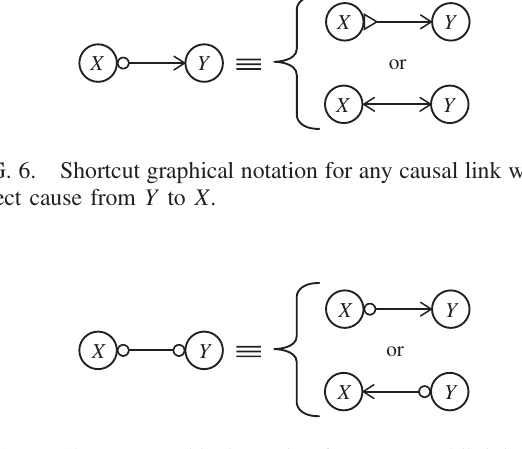
FIG. 9. DAG elimination from d -separation in Step 2a. The diagrams in this and the following figures should be read as follows. Each graph represents the set of all DAGs that contain only causal connections compatible with each shortcut notation. Solid lines require a compatible causal connection, and dashed lines are compatible with no connection. On each arrow between graphs, we eliminate all graphs that are incompatible with the d -separation condition indicated.